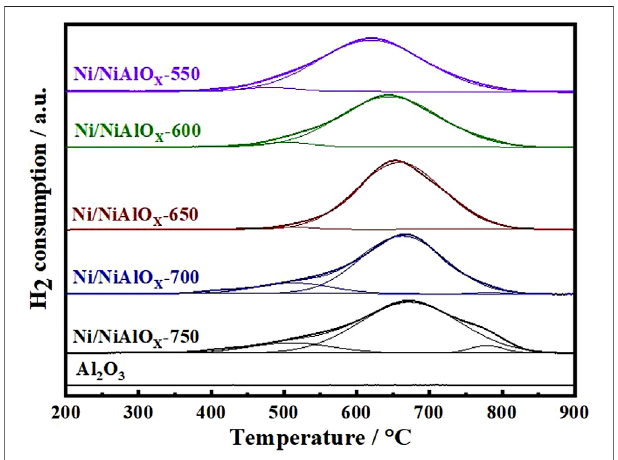
FIGURE 2 | H 2 -TPR pro fi les of Ni/NiAlO y catalysts with different calcination temperatures.